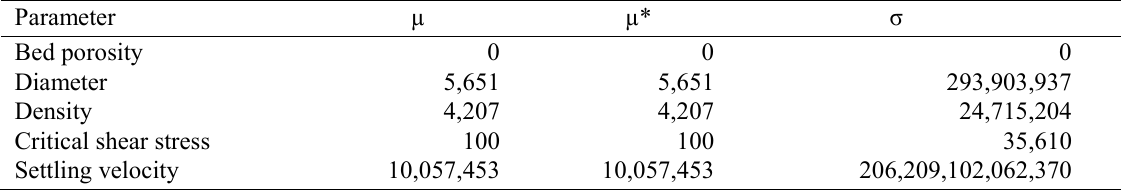
Table 1 Results of the elementary effects method for the IWRS model (“,” used as thousands separator). Parameter µ µ* σ Bed porosity 0 0 0 Diameter 5,651 Density 4,207 Critical shear stress 100